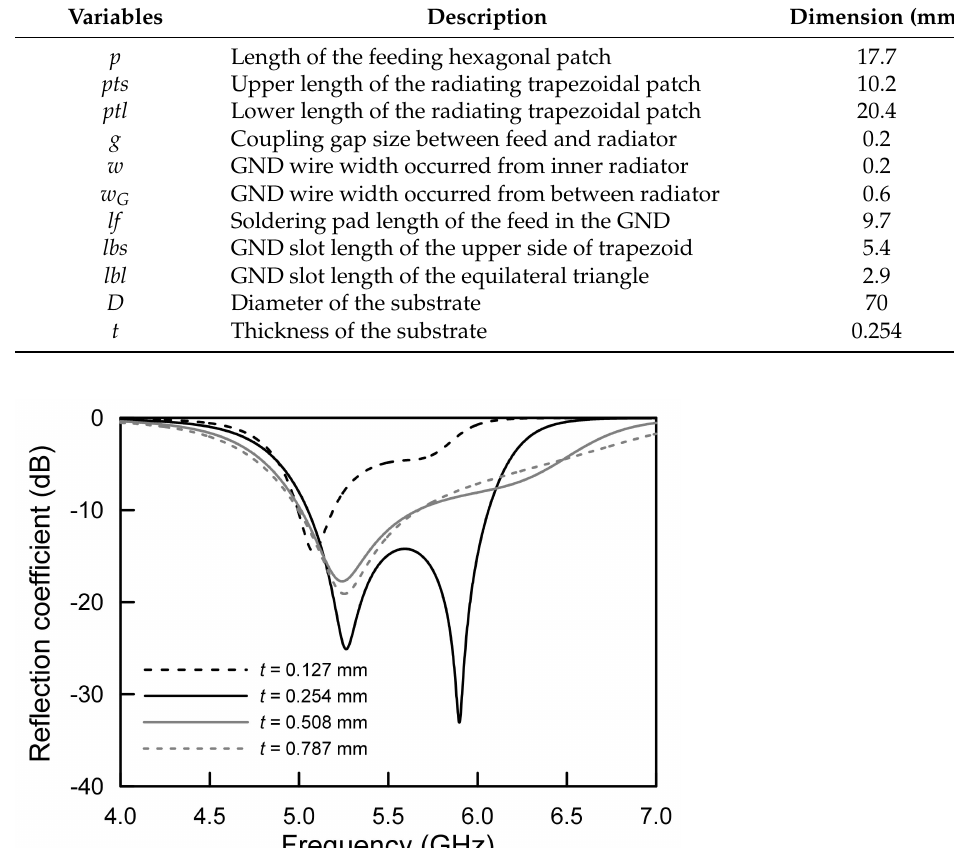
Figure 1. Configuration of the proposed antenna. Table 1. Optimized all of dimensions of the proposed antenna parameters.